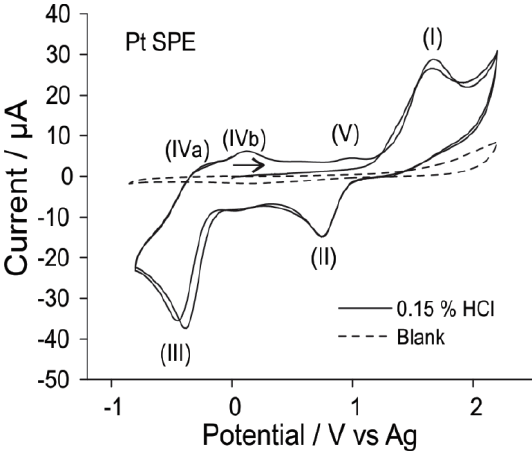
Figure 4. CV (two cycles) for the oxidation of 0.15% hydrogen chloride gas (nitrogen fill) on a Pt SPE in [C 2 mim][NTf 2 ] at a scan rate of 0.1 V/s. Dotted line is the response in the absence of hydrogen chloride